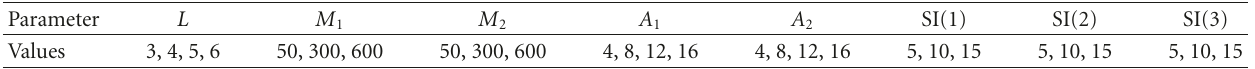
Table 3: Values for di ff erent parameters.